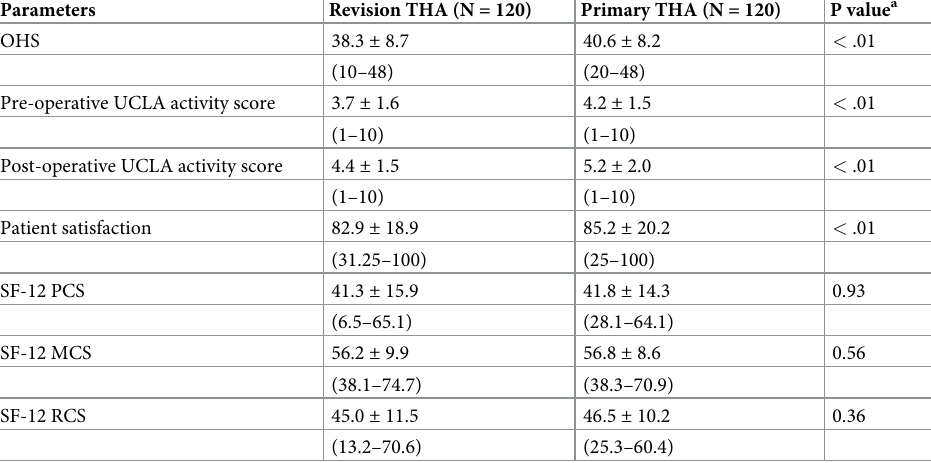
Table 3. Summary of patient-reported